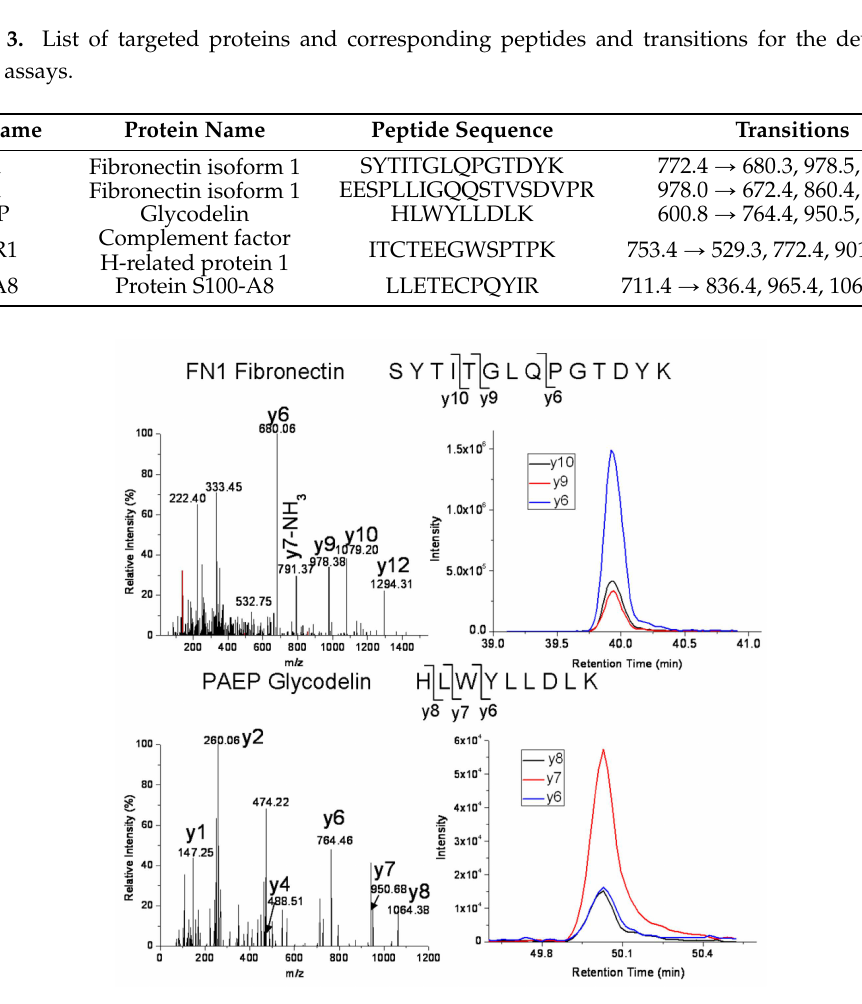
Figure 2. Examples of validation of peptides for two of our targeted candidate proteins by MRM-triggered MS/MS ( left panels) and optimization of the transitions for serum MRM assays ( right panels). The illustrated validated peptides derive from fibronectin ( top ) and glycodelin ( bottom ),